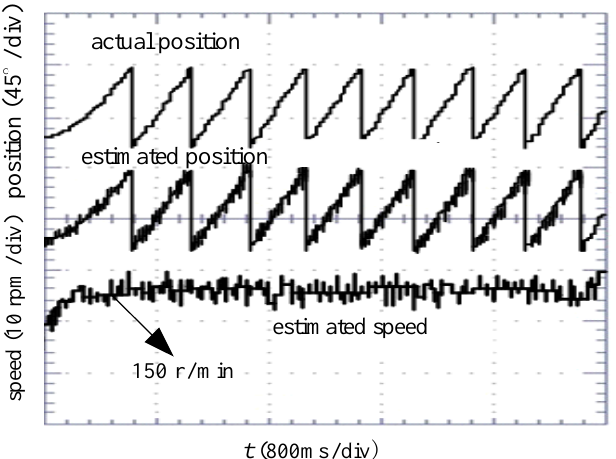
Figure 12. Experimental results of rotor position and speed.